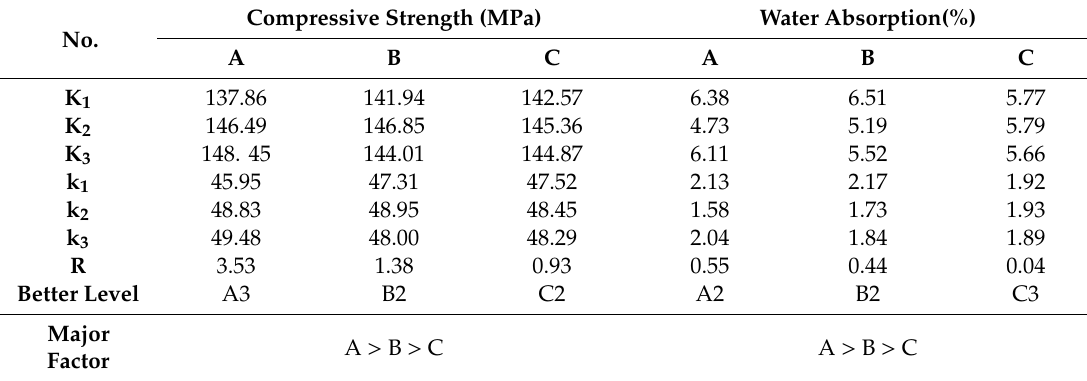
Table 4. Analysis of each